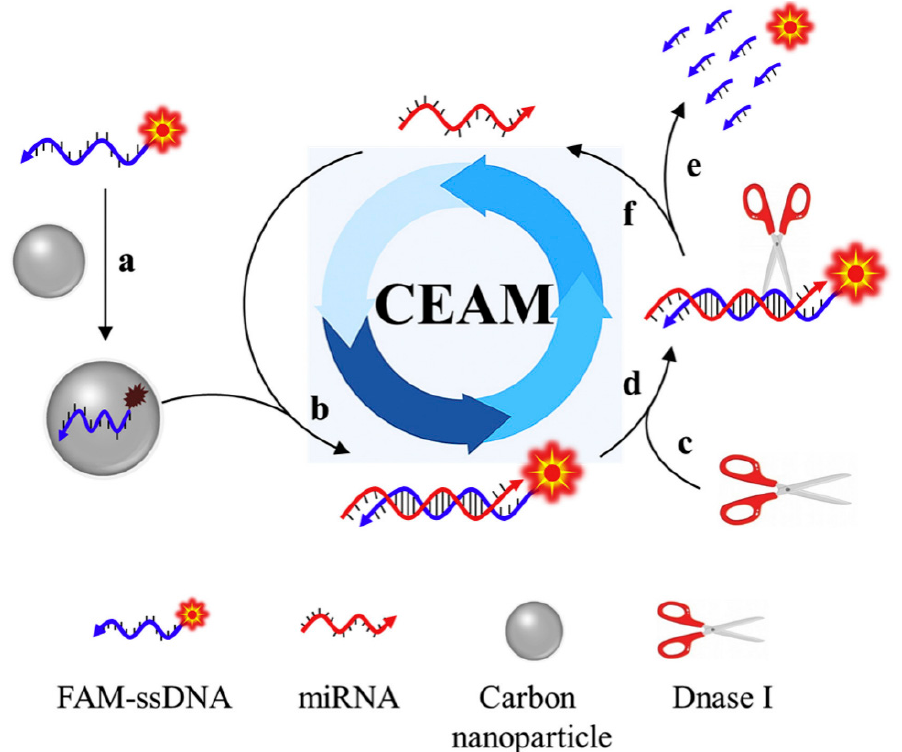
Figure 4. The operating principle of cyclic enzymatic amplification method (CEAM) for miRNA study. Primarily, FAM-tagged single-stranded DNA (FAM-ssDNA) coupled to the carbon nanoparticle surface (route a ) give rise to a substantially quenched fluorescence signal. Formation of RNA/DNA hybrid (route b ) upon introducing the target miRNA. The resultant attachment of DNase I (route c ) identifies its suitable substrate: RNA/DNA hybrid (route d ). Consequently, FAM-ssDNA is digested into a tiny portion and a strong fluorescence signal is produced (route e ). Further, miRNA remains undisturbed and returns to its former status (route f ), which is set up to initiate other reaction cycles; hybridisation, digestion, signaling and release. The recycling application of the target molecule provides an opportunity to successfully augment the detection sensitivity. Adapted from Ref. [75] with authorisation from